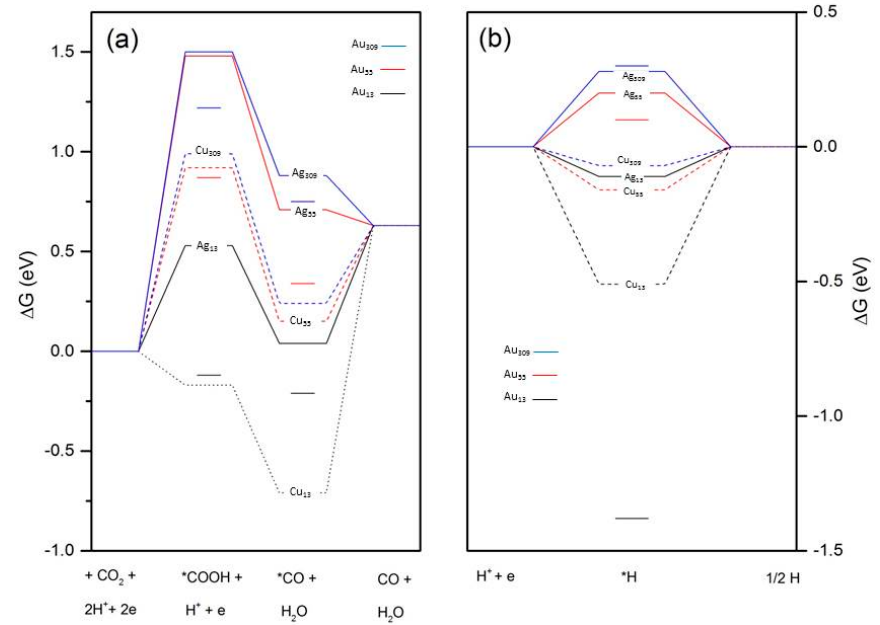
Figure 4. Free energy diagrams for ( a ) CO 2 RR and ( b ) HER on Au, Ag and Cu NPs. Adapted and reprinted with permission from Ref [37]. Copyright (2017) Materials Research Society.